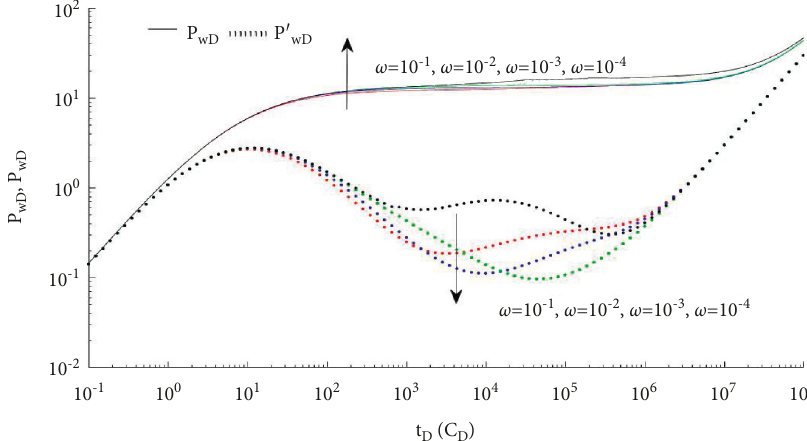
Figure 5: .Dimensionless pressure of vertical wells under the close outer boundary influenced by ω ( C